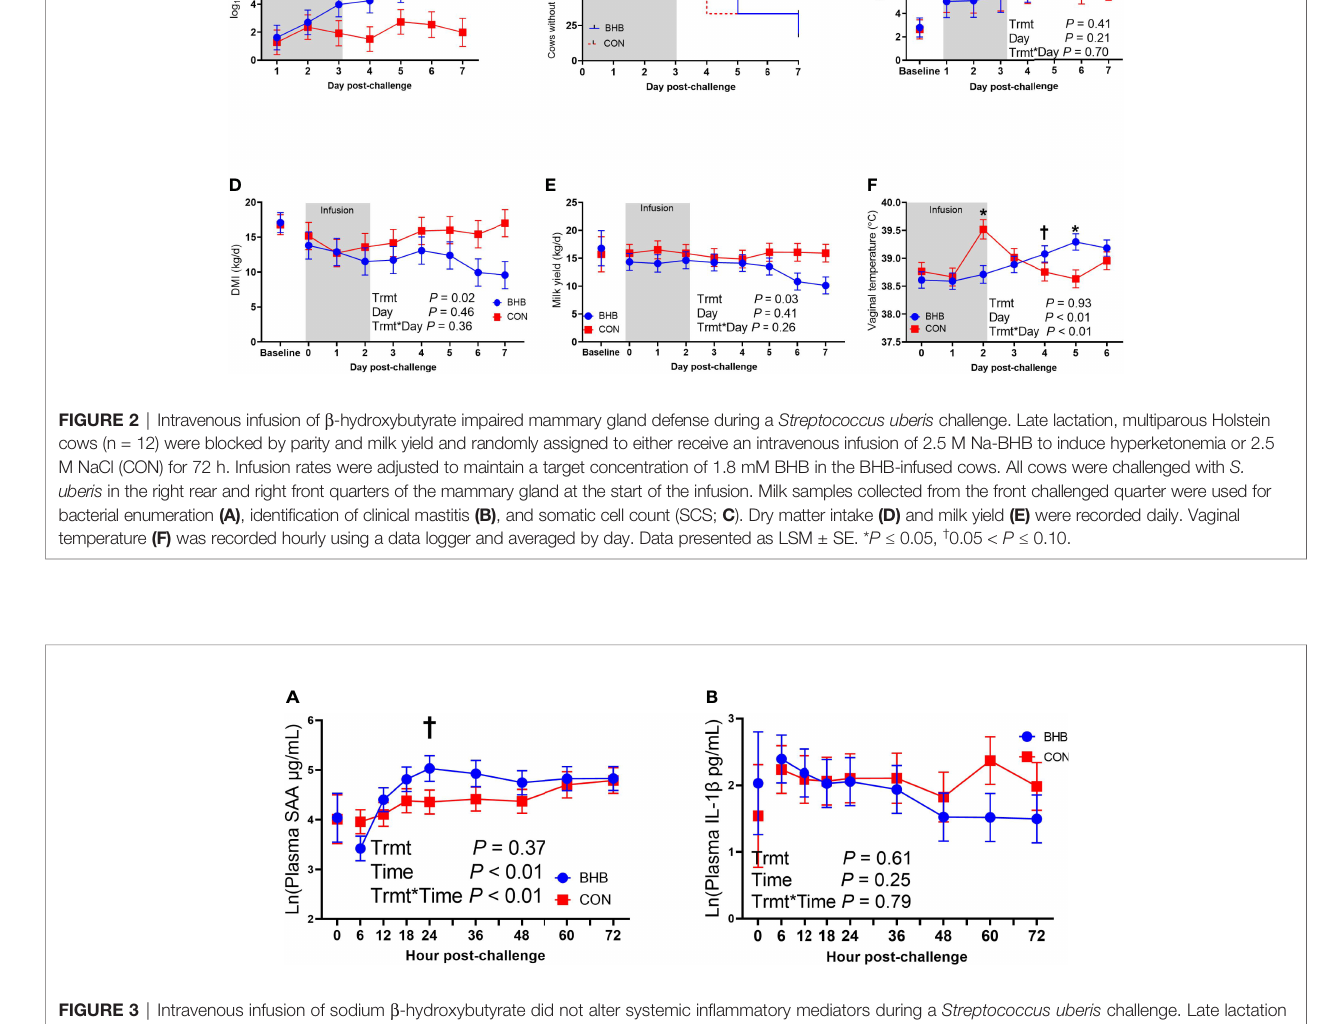
FIGURE 3 | Intravenous infusion of sodium b -hydroxybutyrate did not alter systemic in fl ammatory mediators during a Streptococcus uberis challenge. Late lactation multiparous cows (n = 12) were blocked by parity and milk yield and randomly assigned to either receive an intravenous infusion of 2.5 M Na-BHB to induce hyperketonemia or 2.5 M NaCl (CON) for 72 h. Infusion rates were adjusted to maintain a target concentration of 1.8 mM BHB in the BHB-infused cows. All cows were challenged with S. uberis in the right rear and right front quarters of the mammary gland at the start of the infusion. Blood samples were collected every 6 to 12 h during the 72 h infusion. Serum amyloid A (SAA; A ) and interleukin-1 b (IL-1 b ; B ) concentrations were determined using a bovine speci fi c ELISA. Data presented as LSM ± SE. † 0.05 < P ≤